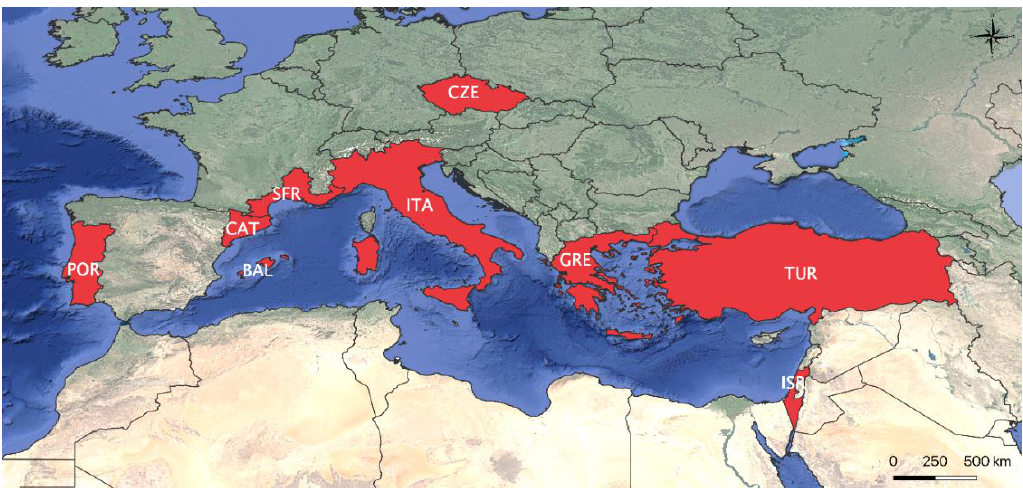
Figure 1. The study areas location (in red). Legend—CZE: Czech Republic; ISR: Israel; ITA: Italy; TUR: Turkey; GRE: Greece; POR: Portugal; SFR: South France; CAT: Catalonia; BAL: Balearic Islands.